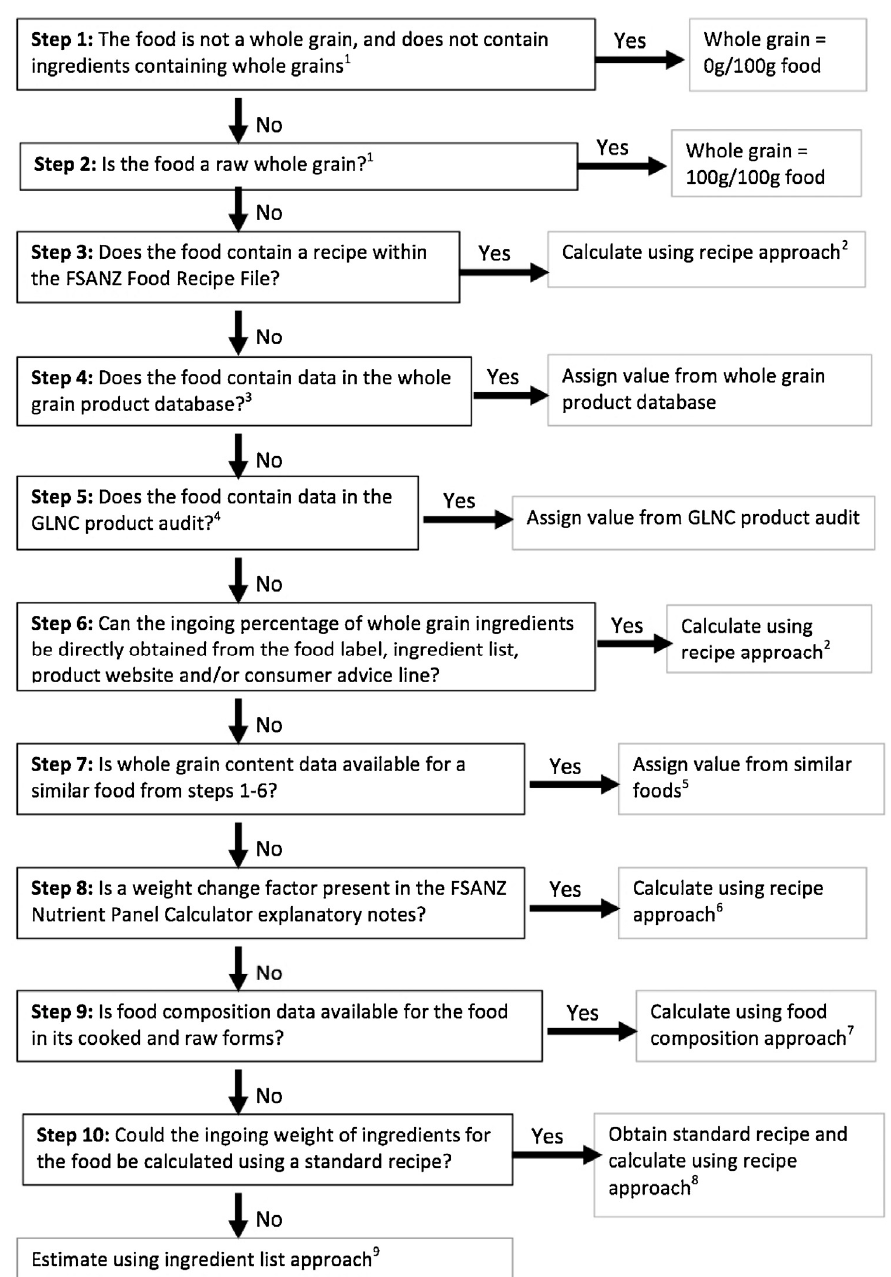
Figure 1. Schematic process for calculation of wholegrain content of foods within the AUSNUT 2011-13 Food, Supplement, and Nutrient Database [28]. Reprinted from The Journal of Food Composition